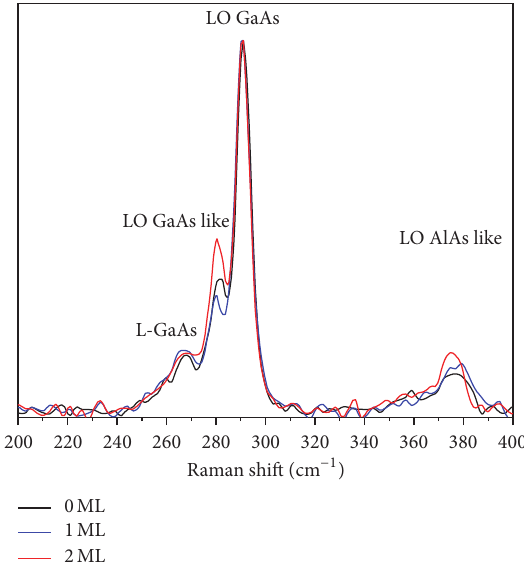
Figure 9: Raman scattering of M1, M4, and M5 heterostructures capped with a 25 nm GaAs layer and passivated with 0, 1, and 2 Si- ML, respectively. A 532 nm laser was used as excitation source.